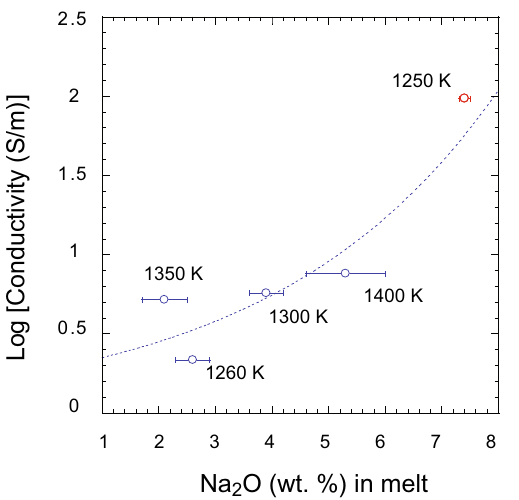
Figure 5. Electrical conductivity of silicate melt as a function of Na contents. The electrical conductivity of melts produced by dehydration and melting of amphiboles such as, ferri-kaersutite 7 , actinolite 7 , hastingsite 7 , tremolite 7 , and glaucophane (present study) at 1.5 GPa are plotted against the Na 2 O contents in the melt. The uncertainties in composition and electrical conductivities are smaller than the symbol size. The highest temperatures of electrical measurements are shown next to individual